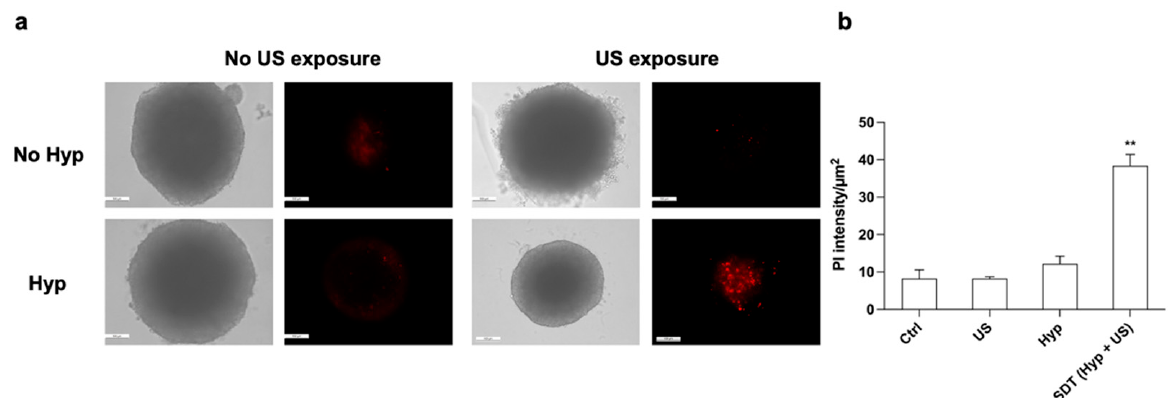
Figure 13. Effects of Hyp-mediated sonodynamic treatment on HT-29 spheroids. ( a ) Representative optical (bright field) and fluorescence (propidium iodide staining in red) images acquired 48 h after the spheroid treatment as follows: untreated spheroid, spheroid incubated with 0.2 µ M Hyp, spheroid exposed to US (1.5 W/cm 2 at 1.5 MHz, continuous wave mode for 5 min), and spheroid treated with SDT (0.2 µ M Hyp + US). Magnification: 10 × , scale bar: 100 µ m. ( b ) Quantification of PI fluorescence intensity in HT-29 spheroids after the different treatments. Statistically significant difference of treated cells versus untreated cells: ** p ≤ 0.01 ( n = 3).